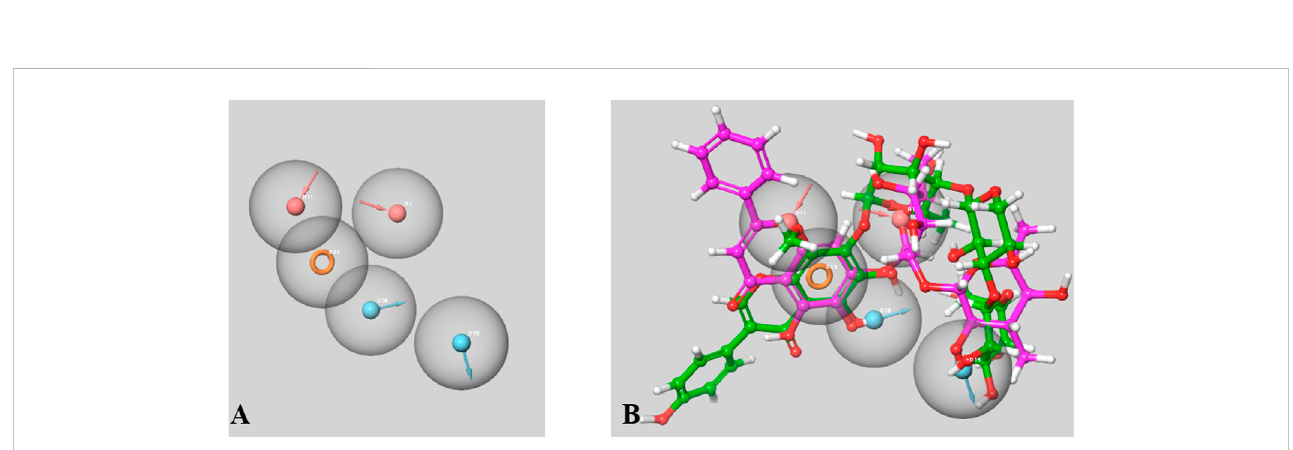
FIGURE 14 AFive-pointPharmacophoremodel(AADDR_3)generatedbyPHASE (A) .Themodelillustratesacceptorfeature(redsphere),donarfeature(bluesphere) and aromatic rings (orange ring) features. Both active phtoconstituents Baicalein-7-O-diglucoside (represented in magenta) and 4 ′ ,5,6,7-Tetrahydroxy-8- methoxyiso fl avone-7-O-beta-D- galactopyranosyl-(1 → 3)-O-beta-D-xylopyranosyl-(1 → 4)- O-alpha-L-rhamnopyranoside (represented in green) overlapped on the generated model AADDR_3 (B)